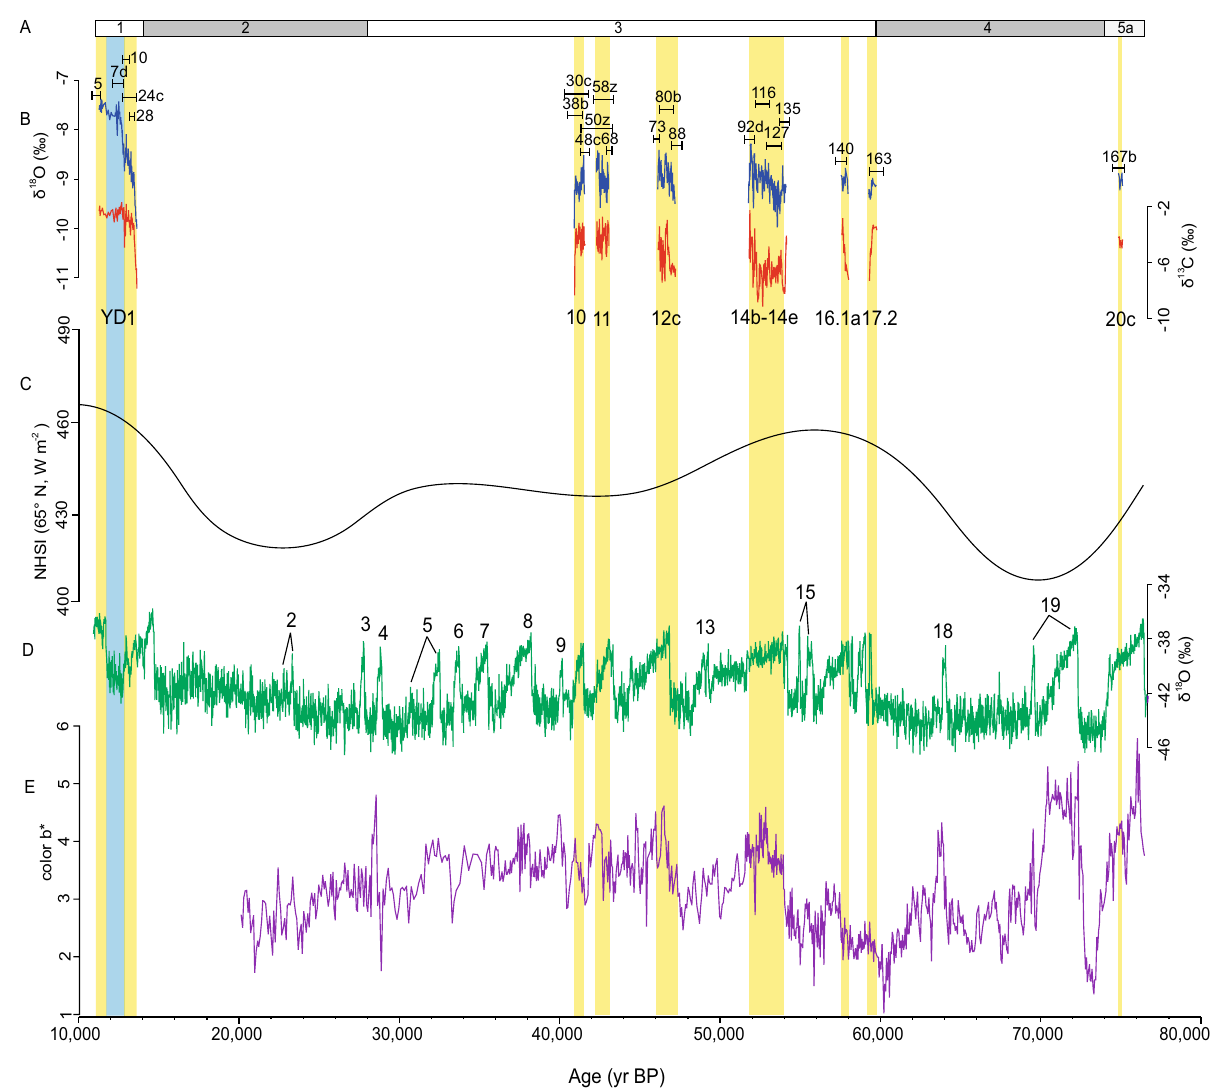
Figure 3. ( A ) Timing of Marine Isotope Stages 5a to 1 45 . ( B ) El Capitan Cave speleothem EC-16-5-F carbon and oxygen isotope record. Black bars show 2σ errors of the speleothem U-Th ages with corresponding sample numbers in Table 1. ( C ) NHSI (Northern Hemisphere summer insolation, 21 July) at 65°N 35 . ( D ) NGRIP oxygen isotope record 30 . ( E ) Color B* spectral analyses from core S0201-2-85KL 12 . Yellow vertical bars are used to highlight speleothem EC-16-5-F growth